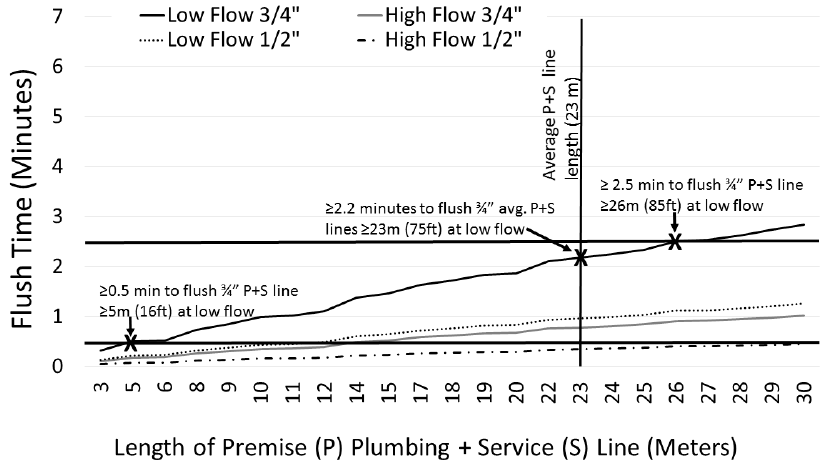
Figure 2. Estimated time to flush premise plumbing (P) and service line (S) (minutes) based on water flow rate (liters per minute), pipe diameter (3/4 or 1/2 inches) and survey-reported P + S length (meters) ( n = − 80) [ Note: Low flow: 3.0 m per minute; High flow: 8.3 L per minute].